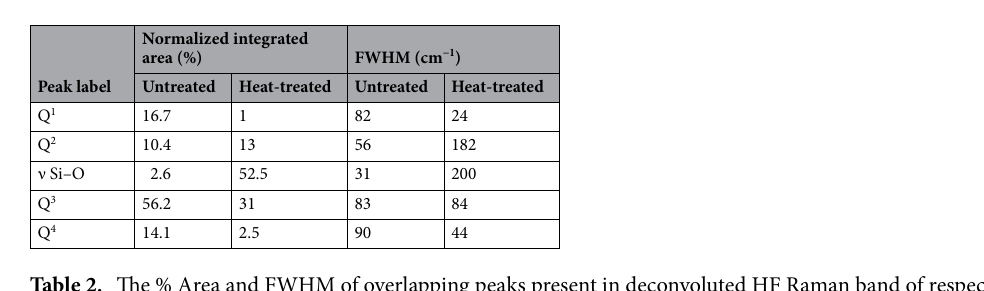
Table 2. The % Area and FWHM of overlapping peaks present in deconvoluted HF Raman band of respective surface scratch